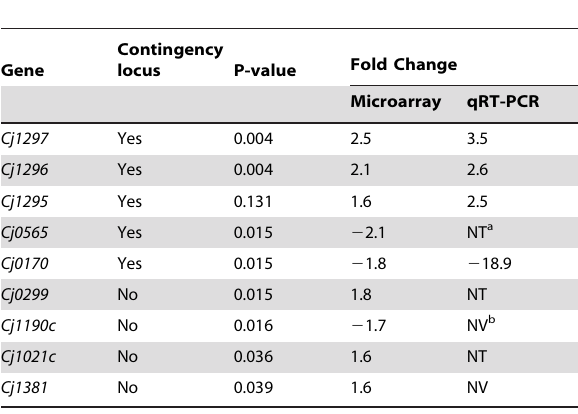
Table 2. Genes differentially expressed in the mouse-adapted variant during in vitro growth.